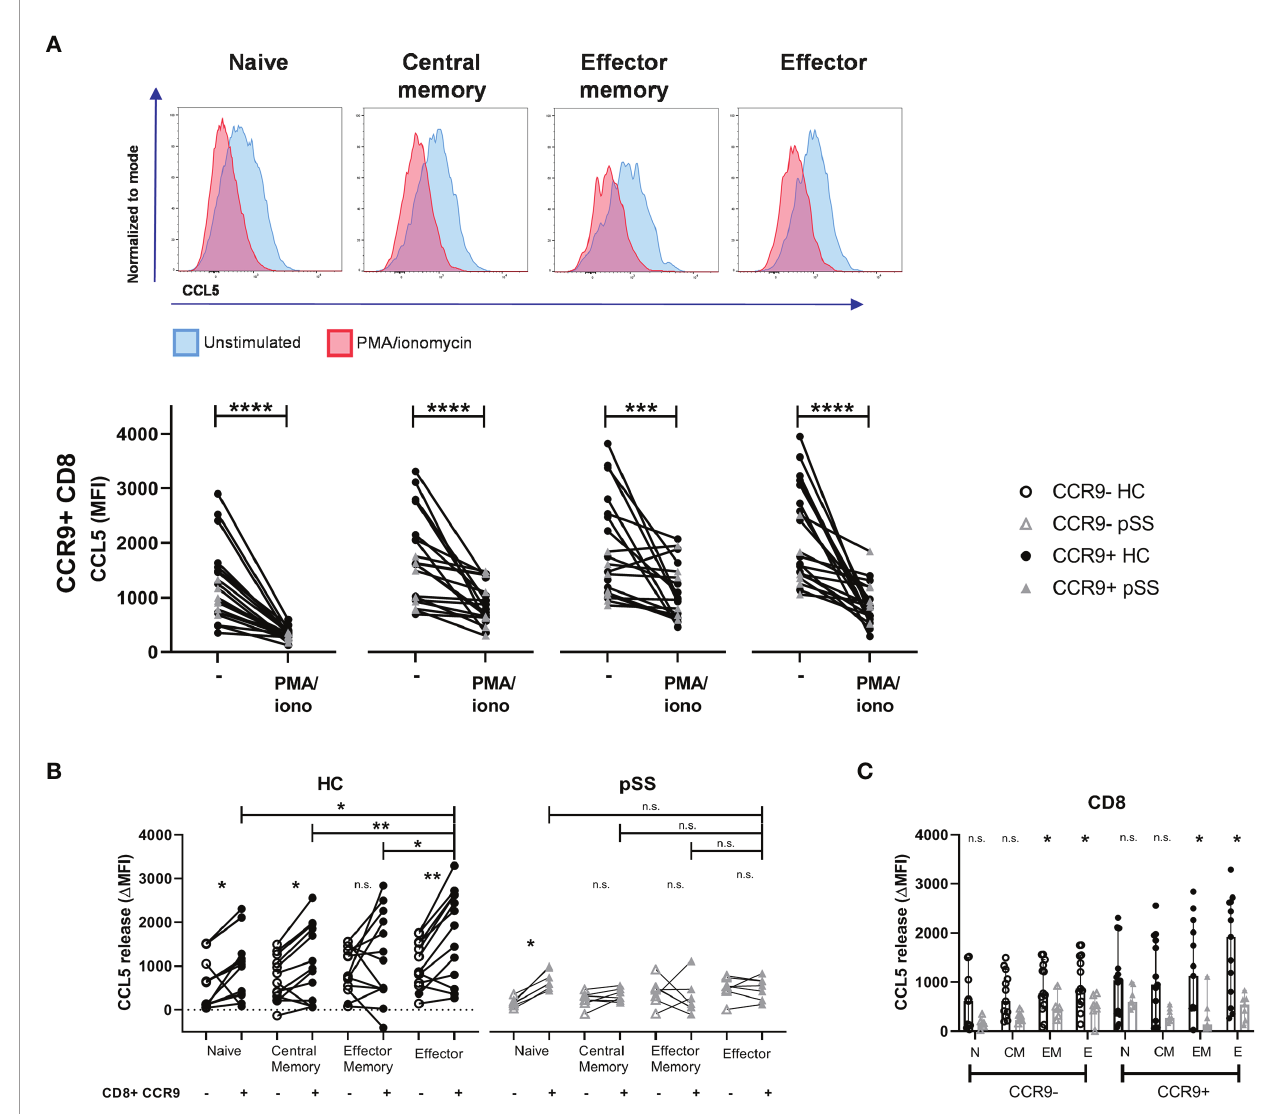
FIGURE 3 | Effector (memory) cells of pSS patients release less CCL5 after stimulation. CCR9+ CD8 T cells from HC release more CCL5 than CCR9- CD8 T cells, which is highest in effector cells. CD27/CD45RO-de fi ned CD8 T cell subsets from n=13 HC and n=7 pSS were analyzed using fl ow cytometry. (A) Representative histograms show CCL5 expression (normalized to mode) of unstimulated (blue) versus PMA/iono stimulated (red) cells with below quanti fi cation for CCR9+ CD8 T cells. (B) Difference in CCL5 expression ( D MFI CCL5) between unstimulated and stimulated CD8 T cells. Graph shows differences in CCR9- and CCR9+ CD8 T cell subsets, both for HC and for pSS patients. (C) Bar plot showing differences between HC and pSS in D MFI CCL5 in CCR9- and CCR9+ CD8 T cell subsets. Naive (N): CD27+CD45RO-; Central Memory (CM): CD27+CD45RO+; Effector Memory (EM): CD27-CD45RO+; Effector (E): CD27-CD45RO-. MFI, mean fl uorescence intensity; D MFI, deltaMFI (CCL5 difference of 4h unstimulated-4h stimulated); pSS, primary Sjögren ’ s syndrome; HC, healthy controls; PMA/iono, phorbol myristate acetate/ionomycin. *, **, ***, **** indicates statistical signi fi cance of p<0.05, 0.01, 0.001, 0.0001, respectively. n.s., not signi fi